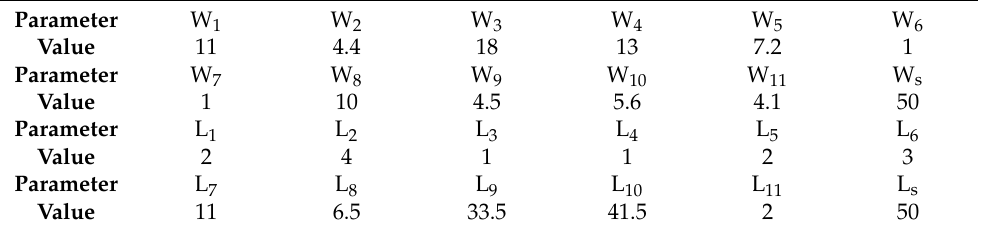
Table 1. Parameters of the presented antenna (unit: mm).